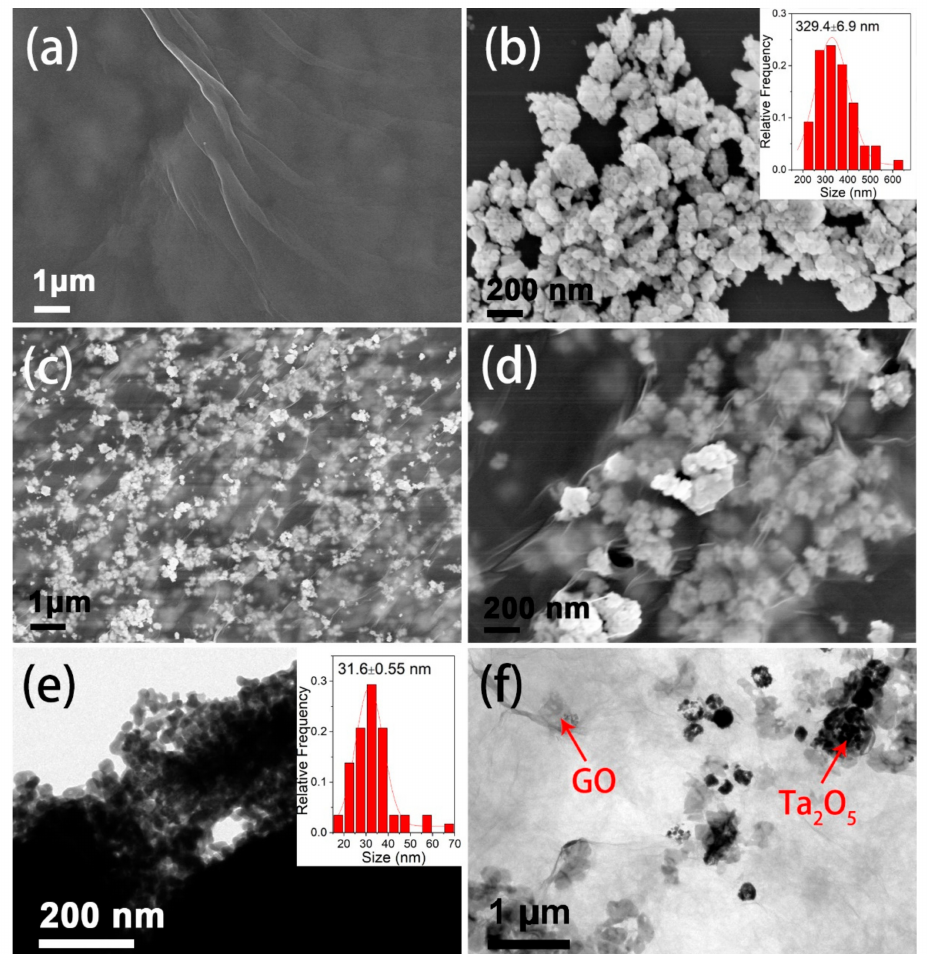
Figure 2. Scanninig electron microscopy (SEM) images of the pure GO ( a ), Ta 2 O 5 nanoparticles with the inset of the size distribution ( b ) and Ta 2 O 5 -GO composite nanoparticles ( c , d ). Transmission electron microscopy (TEM) images of the as-prepared Ta 2 O 5 nanoparticles with the inset of the size distribution ( e ) and Ta 2 O 5 -GO composite nanoparticles ( f